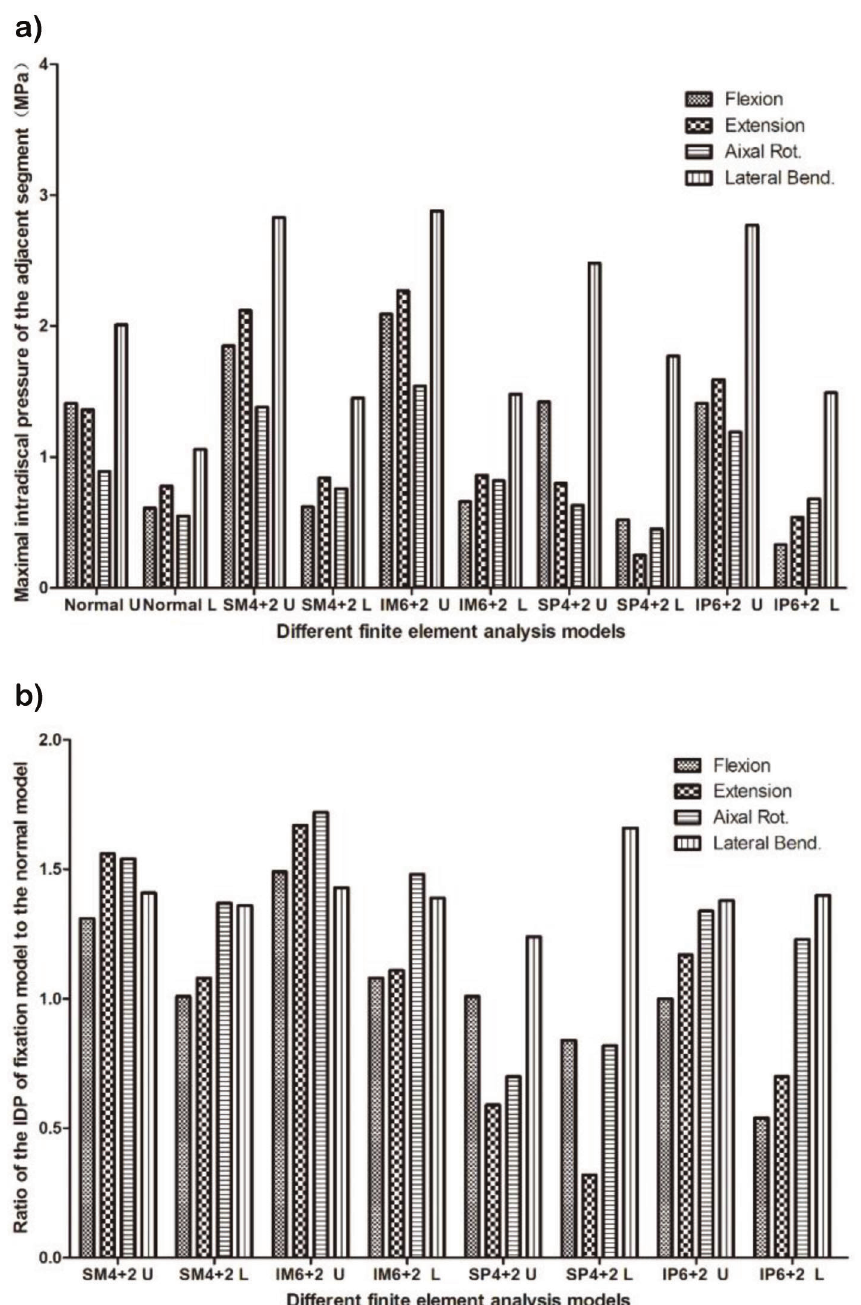
Figure 4 - Intradiscal pressure of the adjacent segment. A. Maximal intradiscal pressure of the adjacent segment. B. Ratio of the IDP of the fixation model to that of the normal model. SM4 + 2/SP4 + 2 : short-segment monoaxial/polyaxial pedicle screw fixation; IM6 + 2/ IP6 + 2 : intermediate monoaxial/polyaxial pedicle screw fixation; U : upper adjacent segment; L : lower adjacent segment; IDP : intradiscal pressure.